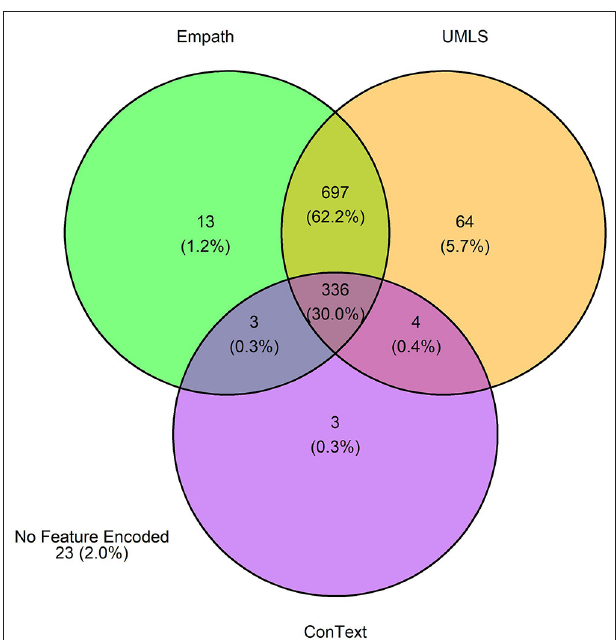
FIGURE 8 | Venn diagram depicting the number of annotations in the training set encoded by each classifier.